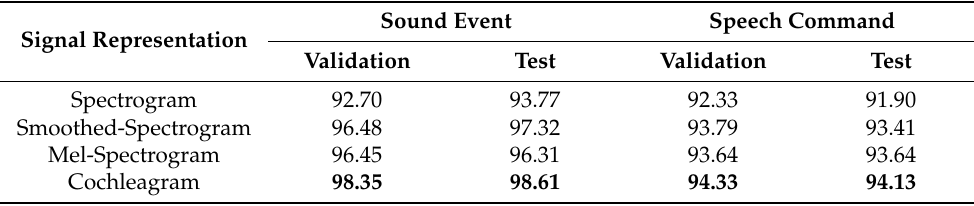
Table 3. Average classification accuracy (in %) of time-frequency image representations.